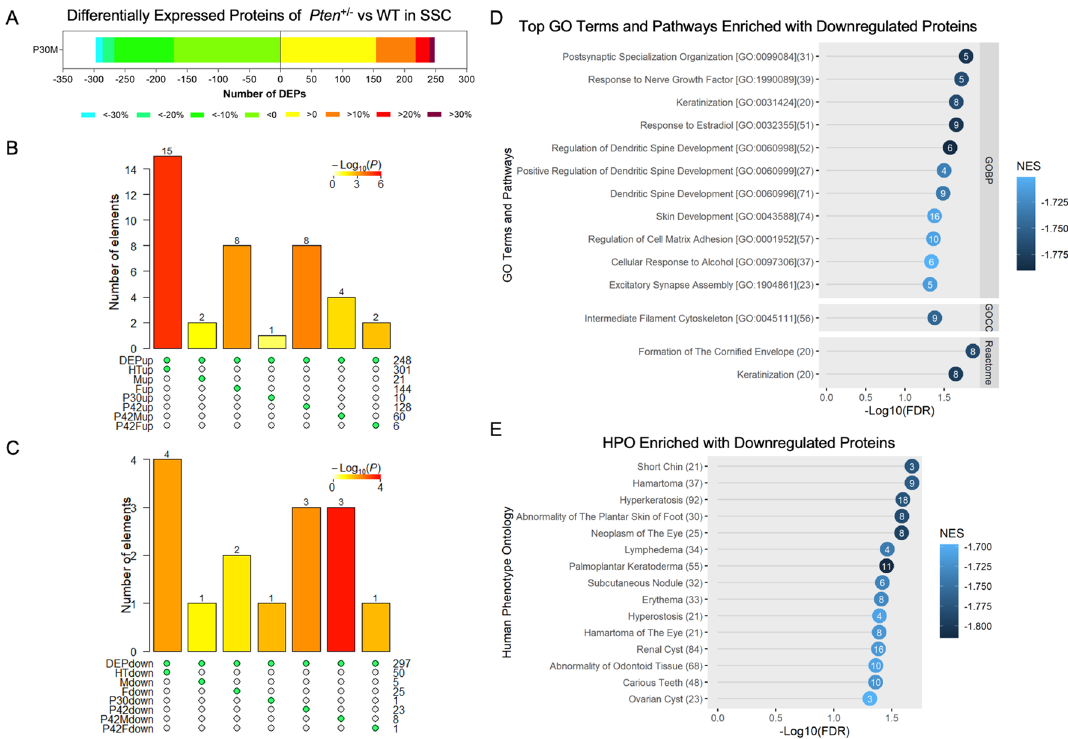
Figure 2. Proteomic analysis of somatosensory cortex of Pten +/− mice. ( A ) Number of differentially expressed proteins (DEPs; false discovery rate < 0.05) stratified by the percentage fold-change in the somatosensory cortex of male Pten +/− mice (n = 3) and littermate controls (WT) (n = 3) at P30. ( B & C ) Upset plots show the number of overlapping differentially expressed genes (DEGs) and DEPs in somatosensory cortices, where DEPup indicates upregulated proteins and DEPdown indicates downregulated proteins. Other groups are DEGs. ( D ) Gene Ontology terms and pathways and ( E ) Human Phenotype Ontology terms significantly enriched with three or more proteins. Number in the rightmost blanket on the left indicates the total number of genes in the term/ pathway. Number in the circle indicates the number of proteins involved in the